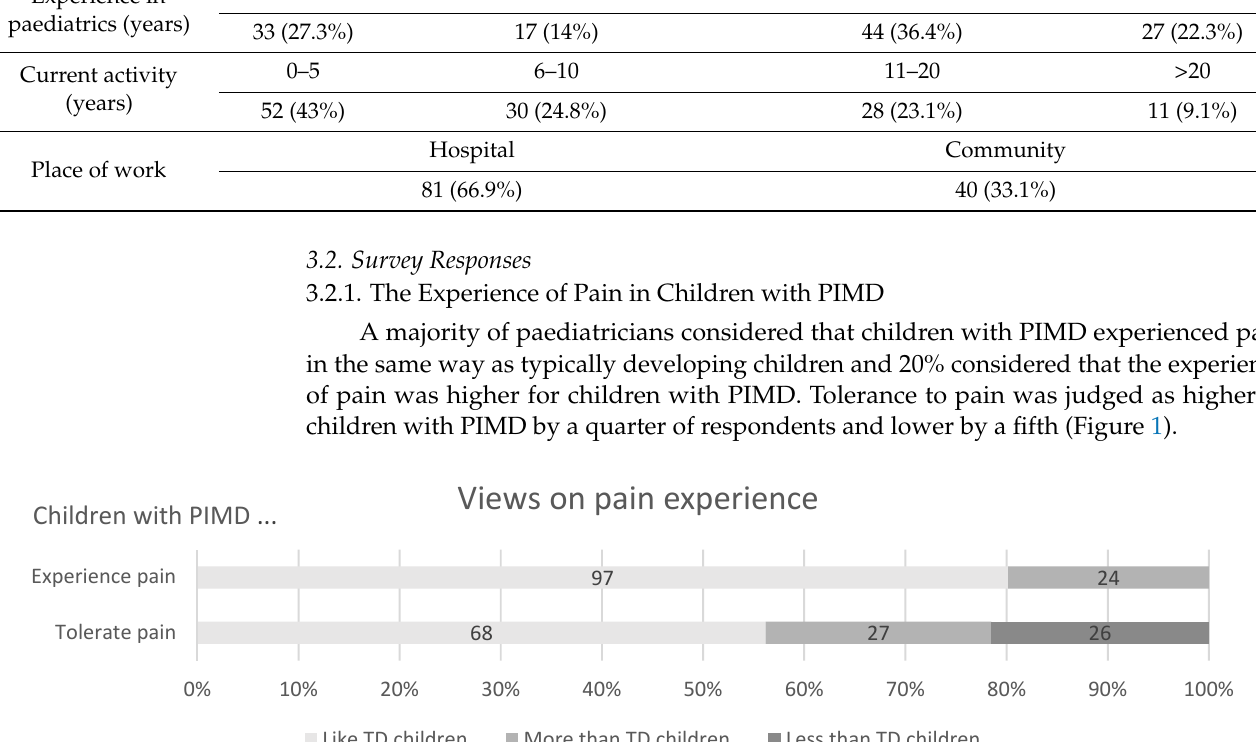
Table 1. Personal characteristics of survey respondents.